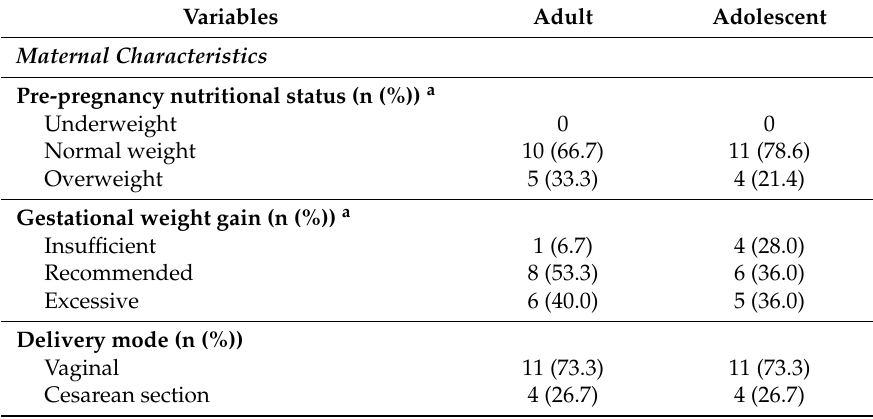
Table 3. Anthropometric variables and obstetric outcomes of adult and adolescent